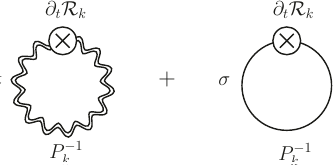
Figure 3 . Behavior of L ( t ) ˜ m 2 . For ω and v we display two cases: (R) v = 0 . 0128638 , ω = − 23 . 1264 and (SFT) v = 0 . 544229 , σ ω = − 0 . 0228639 .